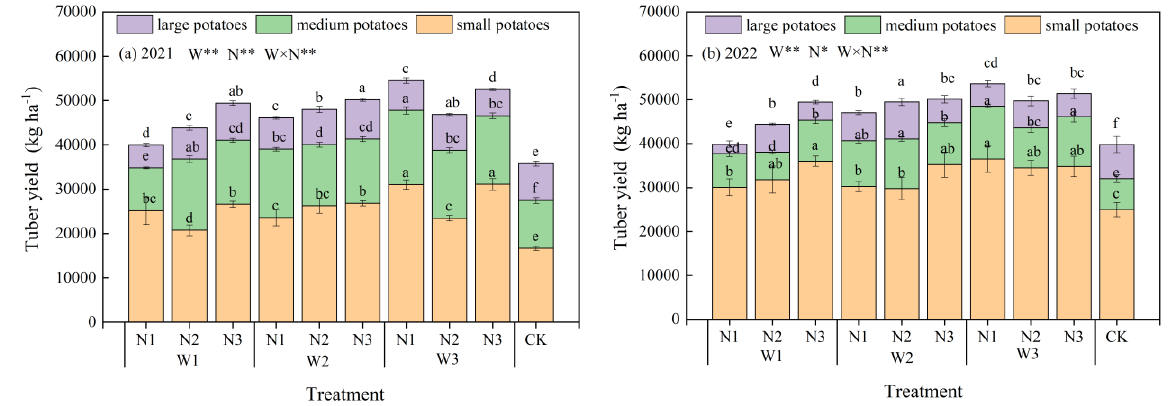
Figure 5. Effects of different water and nitrogen treatments on tuber yield. Note: ( a ) is potato tuber yield in 2021 and ( b ) is potato tuber yield in 2022. * and ** indicate p < 0.05 and p < 0.01, respectively; ns indicates that there was no significant effect ( p > 0.05). N is the nitrogen application rate, and W is the irrigation quota.